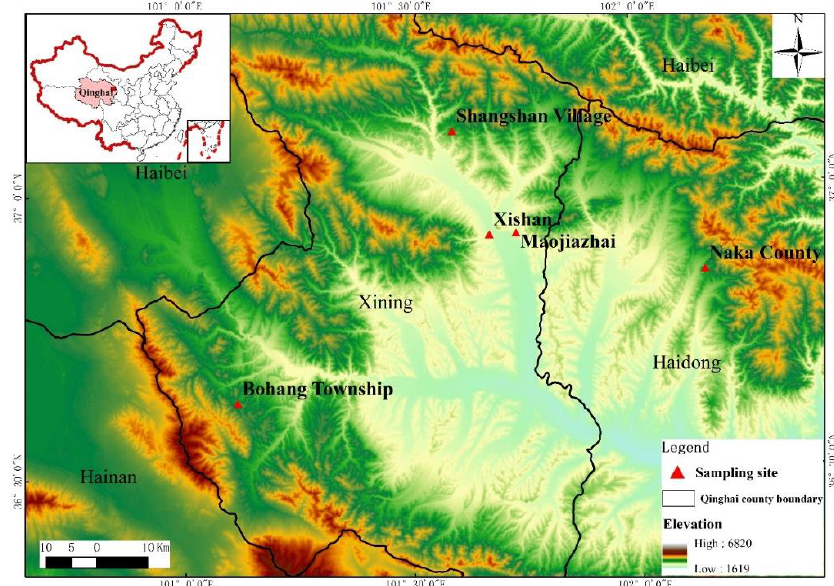
Figure 1. Location of the sampling site.